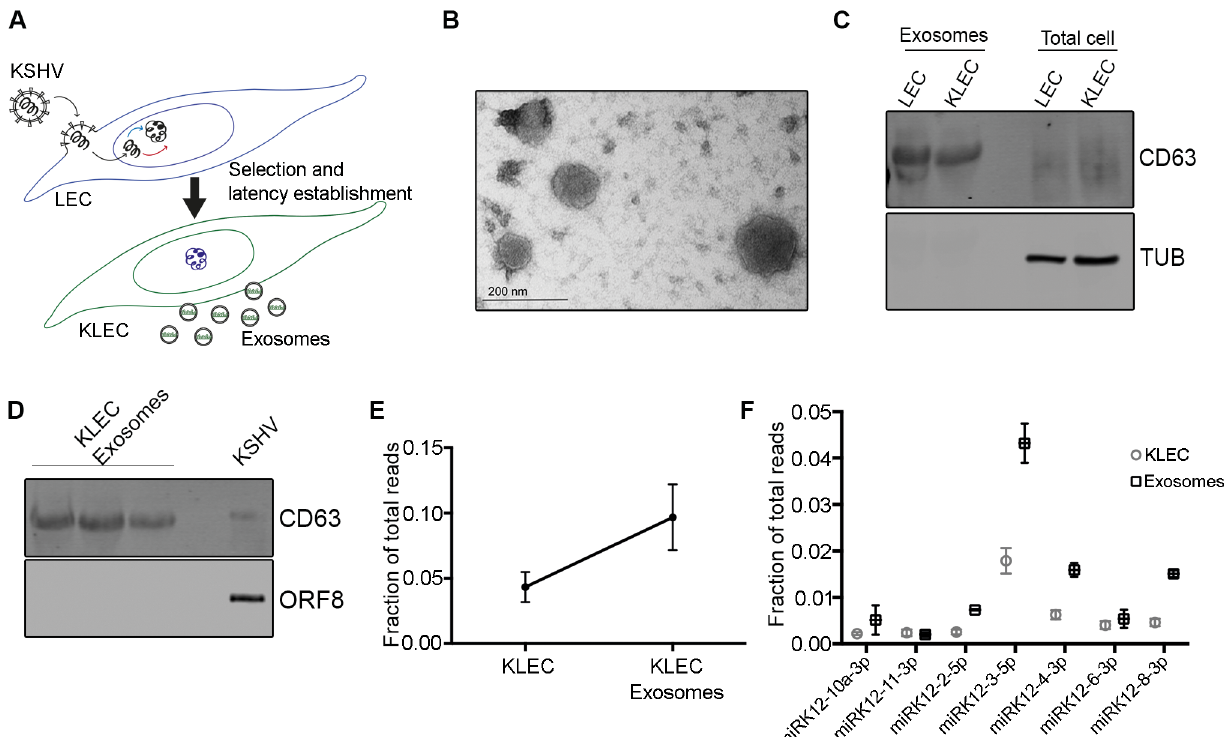
Fig 1. Characterisation of exosomes secreted from KLEC. (A) Schematicillustrationof the procedure used in this study to collect exosomesfrom KLEC. (B) Exosomeswere purifiedfrom KLEC and LEC growth media and analysedby electron microscopy (TEM). Representative image of exosomes from KLEC is shown. (C) Lysates from purifiedexosomes or whole cells were separatedby SDS/PAGE and analysedby immunoblot for expressionof the exosomalmarker CD63. (D) Lysates from purifiedexosomesor KSHV (10 μ g)were separatedby SDS/PAGE and analysedby immunoblot for expression of the exosomalmarker CD63 (top panel)and the viral protein ORF8 (bottom panel). (E) Percentage of the viral miRNAs reads from the total reads detected. (F) Expression levels of selective KSHV miRNAs in KLEC and KLEC-derived exosomes. The expressionlevel was calculatedas fraction of total reads detected in KLEC and KLEC-derived exosomes. Both graphs present the mean and standard error of 3 biologicalrepeats.